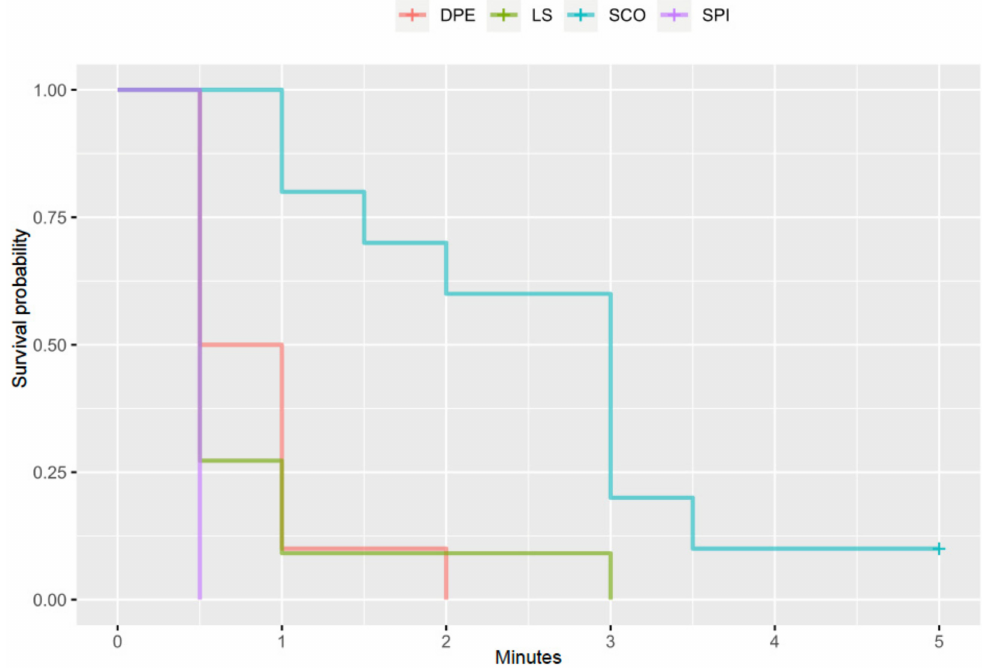
Figure 4. Kaplan–Meier curve of time to event probability of disappearance of the patellar ligament reflex or Westphal’s sign in 41 dogs receiving neuraxial anaesthesia. DPE, dural puncture epidural injection; LS, epidural injection in the lumbosacral space; SCO, epidural injection in the sacrococcygeal space; SPI, injection in the subarachnoid